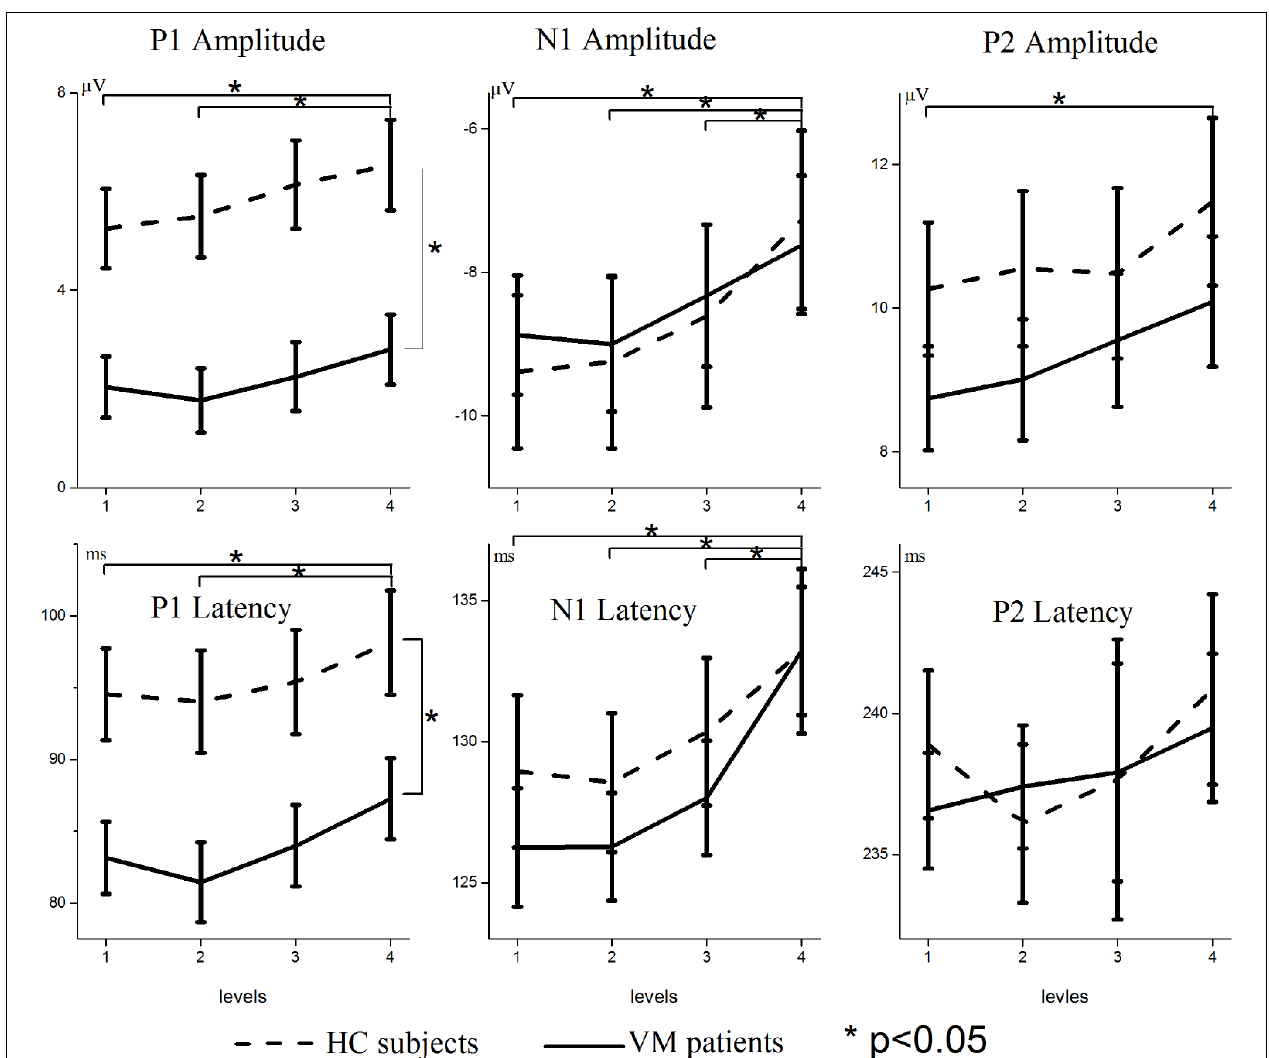
FIGURE 2 | Modulation of scalp-recorded VEPs across different luminance ratios. The amplitudes and latencies of the P1, N1, and P2 VEPs are shown separately for VM patients (solid line) and HC subjects (dashed line). Levels 1 and 4 refer to the smallest (12.5%) and largest (50%) proportions of white pixels in the stimulus pattern, respectively. Asterisks indicate significant differences between VM patients and HC subjects ( p < 0.05). Note the different scaling for different VEP